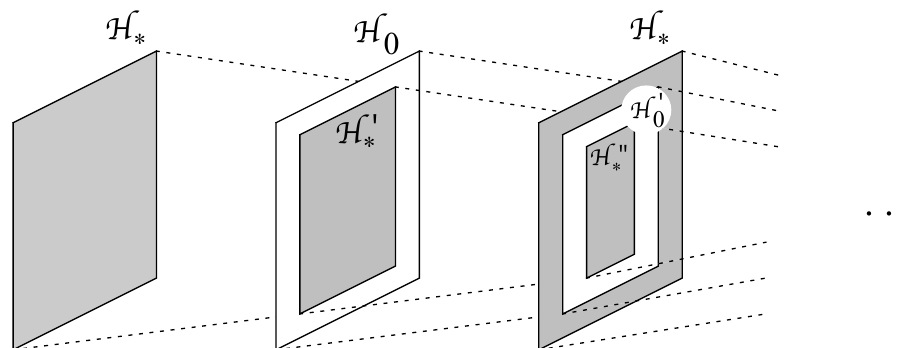
Figure 5 . The (cid:12)eld rede(cid:12)nition between string (cid:12)eld theories on di(cid:11)erent backgrounds is not an isomorphism, but a one-to-one map transforming states of the target D-brane into a subset of states of the reference D-brane. Reversing the role of reference and target backgrounds, it is also possible to map states of the reference D-brane into a subset of states of the target D-brane. Repeated transformation between the reference and target string (cid:12)eld theories embeds the state spaces into ever smaller subsets of